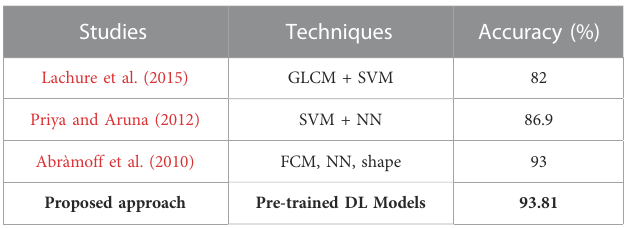
TABLE 6 Comparative accuracy of our proposed model with previous